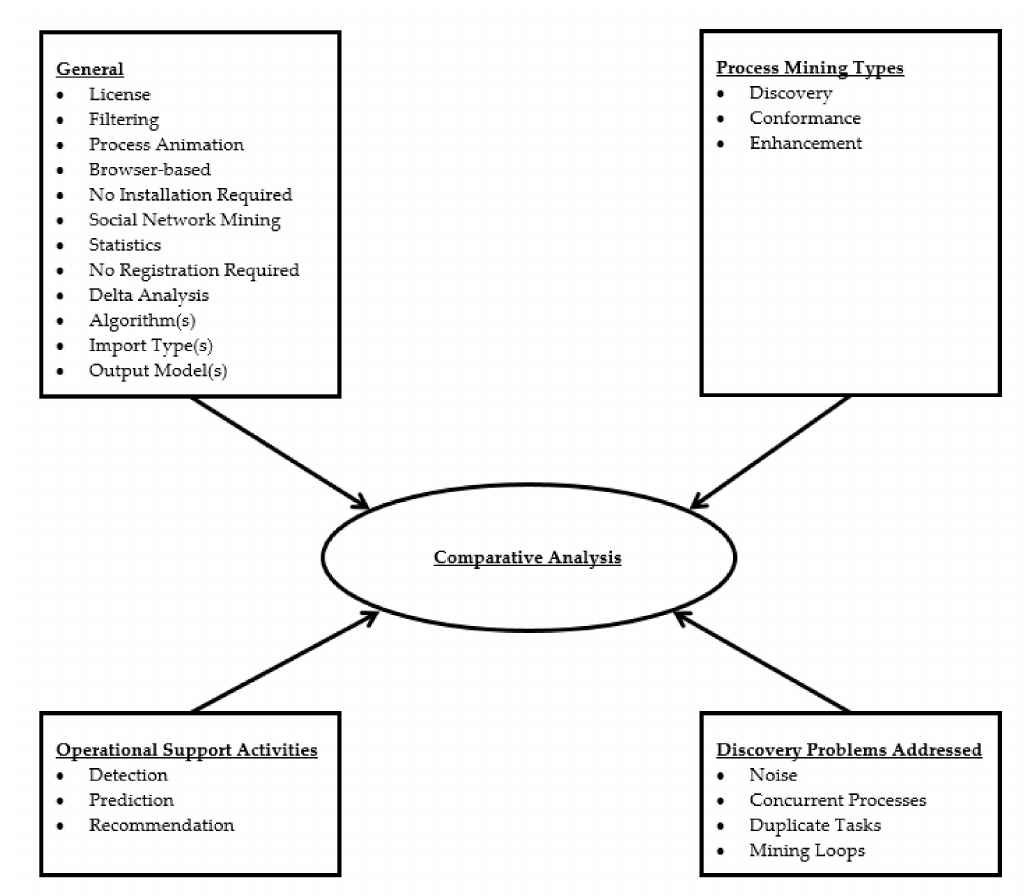
Figure 2. Comparative analysis